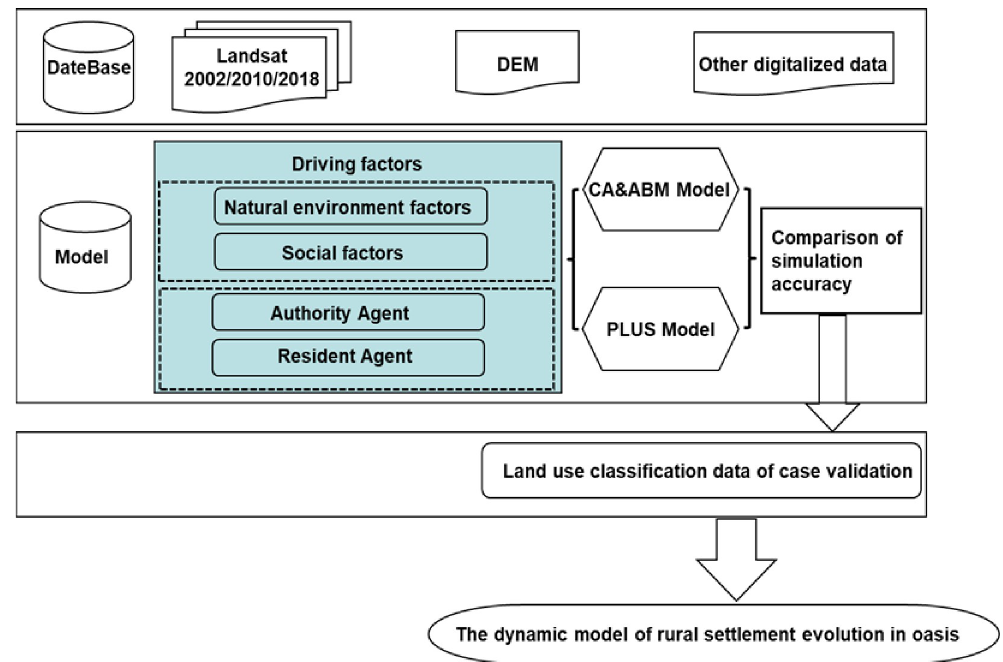
Fig 3. Conceptual framework of the changes of rural settlements in oasis based on CA and ABM.